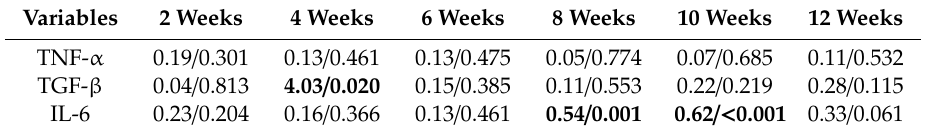
Table 3. Correlation of post- / pretreatment ratio of serum M-CSF levels with the ratios of other factors (r / p value).